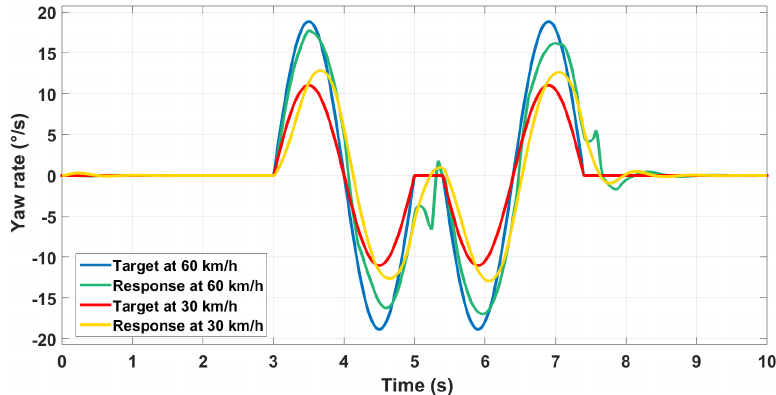
Figure 22. Various speed control using GS H ∞